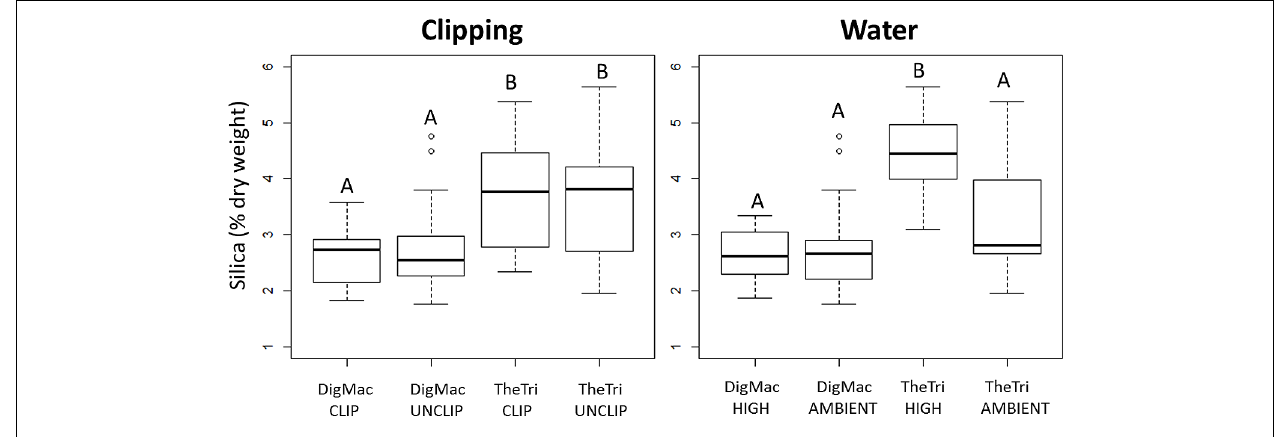
FIGURE 2 | Silica content of Digitaria macroblephara (DigMac) and Themeda triandra (TheTri) leaves as affected by defoliation and watering treatments. Defoliated individuals were clipped to 50% of maximum height bi-monthly a total of four times. High water treatment